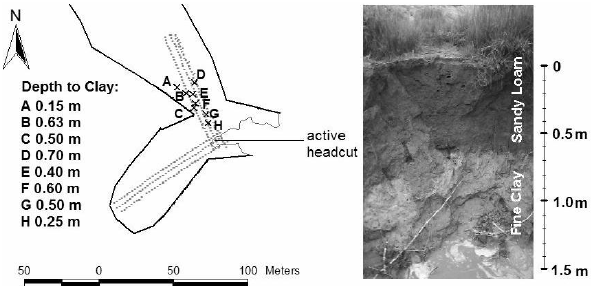
Fig. 15. Locations of auger sample points to clay horizons ( L ) and discernable shallow sandy loam soils over lying deep fine clays of the Kroonstad ( Planosol ) soil form exposed at the site of active gul- lying ( R ).